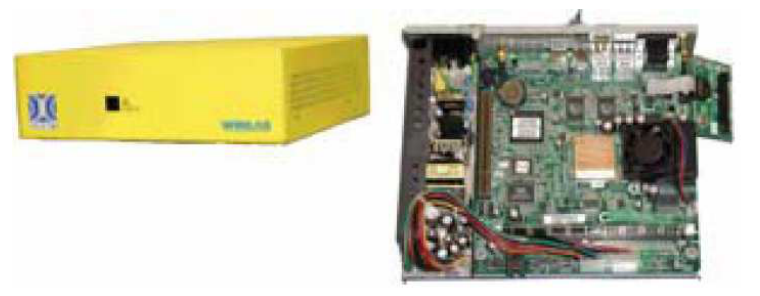
Figure 14. Orbit radio node.